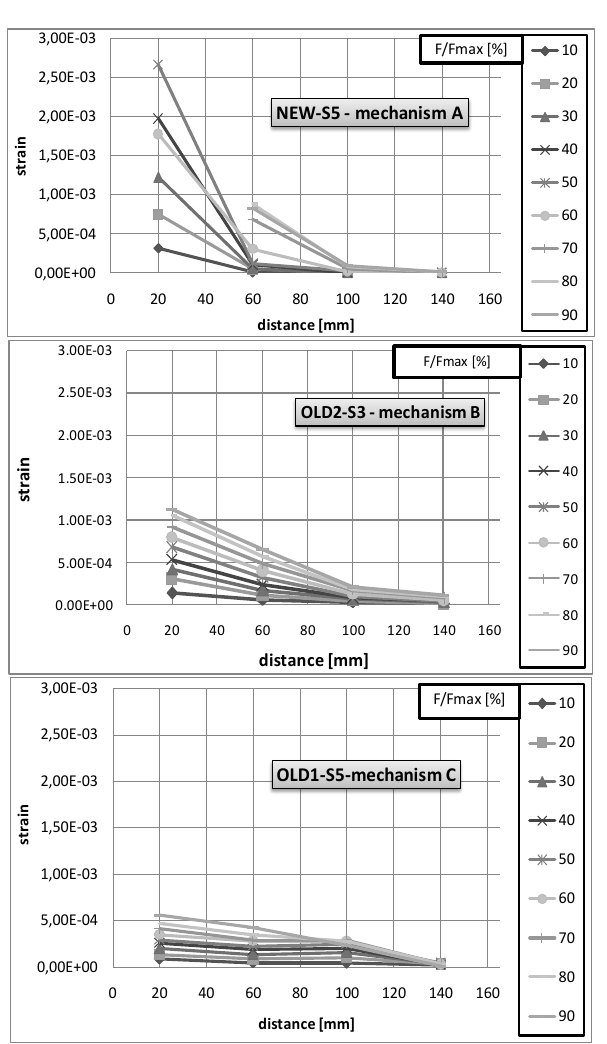
Figure 9. Strain